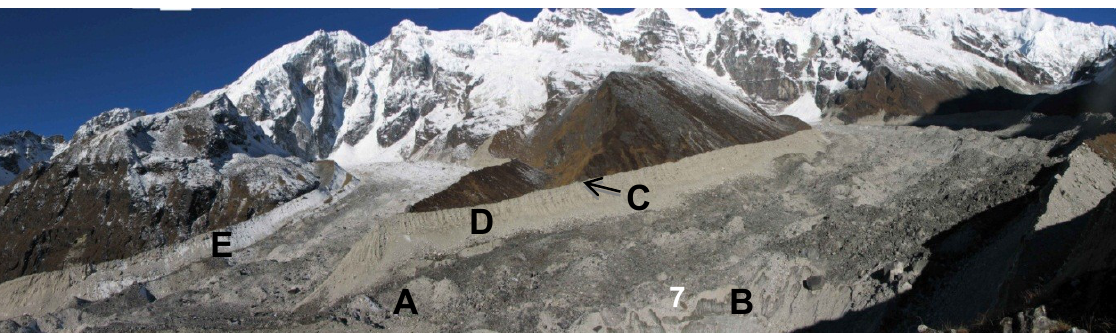
Figure 2. A section of the debris covered tongue of Onglaktang glacier, seen from Goecha La (~5,300 m). The morphology of the debris-cover tongue is visible as cones and mounds (A), and ice walls (B). Also visible is the sharp moraine ridge crest (C), lateral (periglacial) moraine (D) and seasonal snow on the glacier tongue and on the lateral moraines (E). The photograph was taken in November